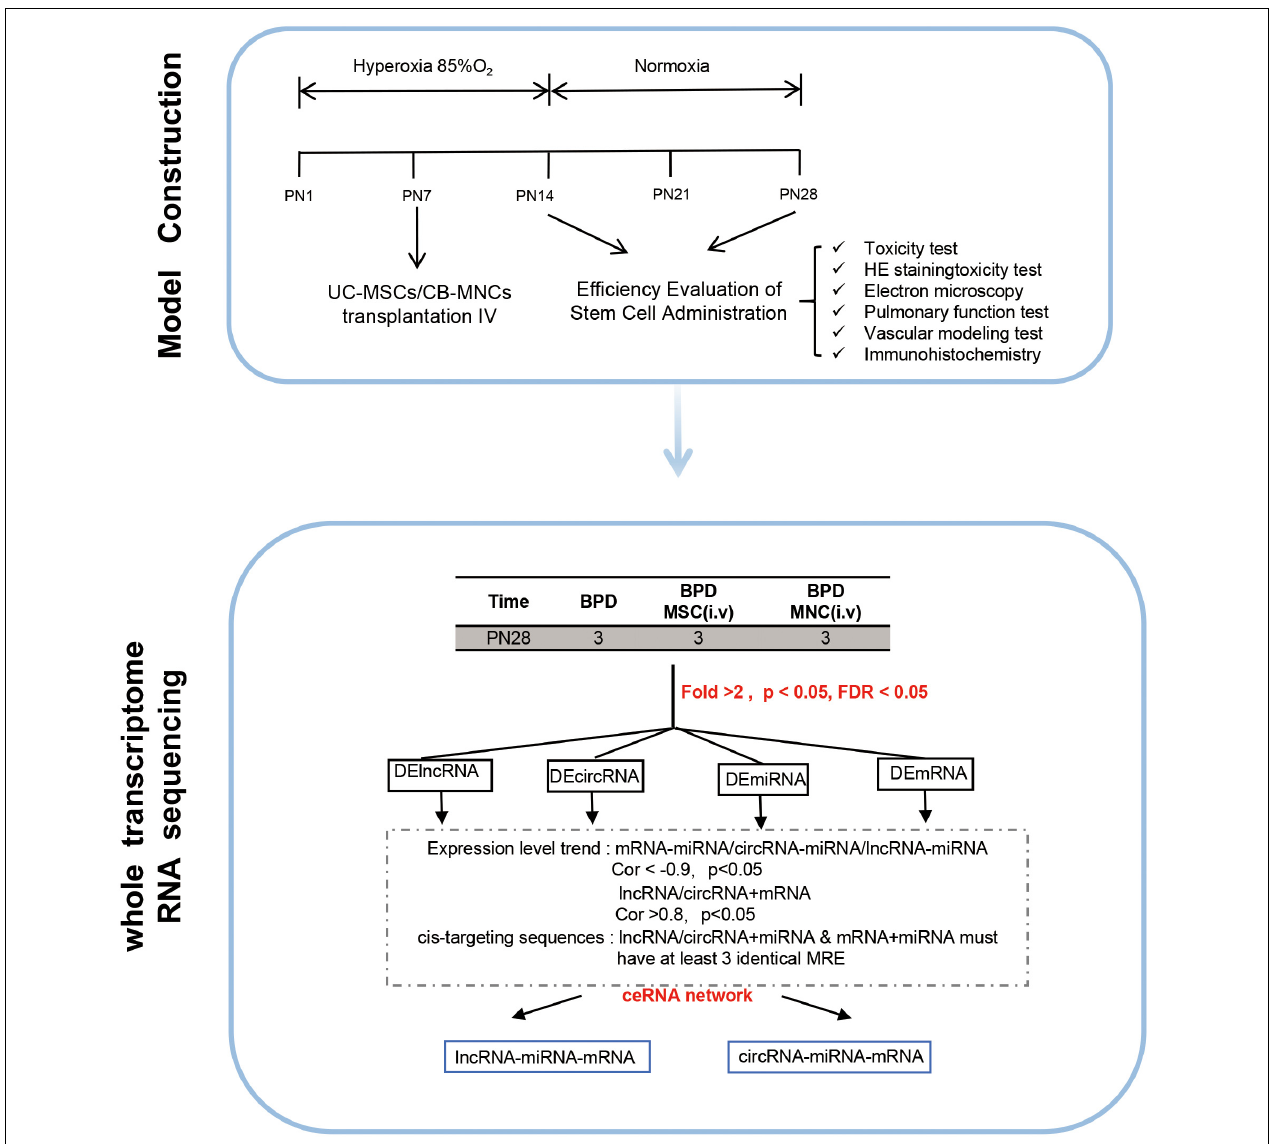
FIGURE 1 | Graphic overview of the study design. The overall scheme of the current research is displayed. Newborn mice (C57 BL/6J) were exposed to hyperoxia (85% O 2 ) for 14 days. Hyperoxia-exposed mice were compared with mice that remained in normoxic conditions (room air). Different indices and parameters evaluating the pulmonary–vascular functions were recorded and calculated. For better investigating the underlying mechanisms, whole-transcriptome sequencing was conducted in indicated groups. Details of the mRNA-seq, miRNA-seq, and circRNA-seq methods are described in the “Materials and